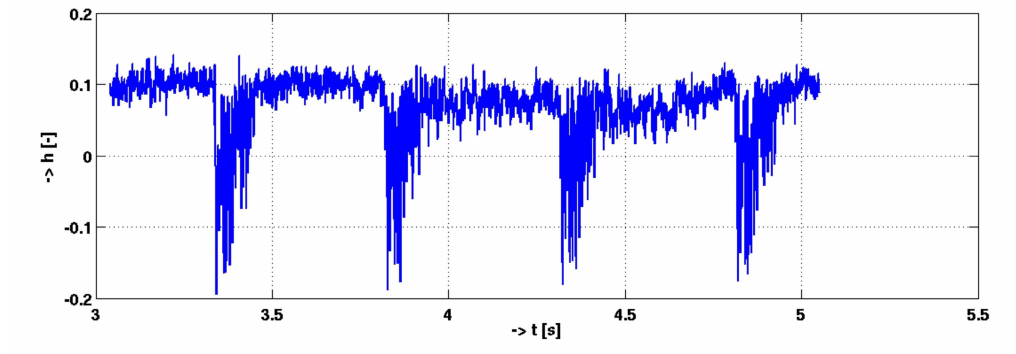
Figure 19. Time-domain signal amplitude evolution from the event location—hammer strokes.